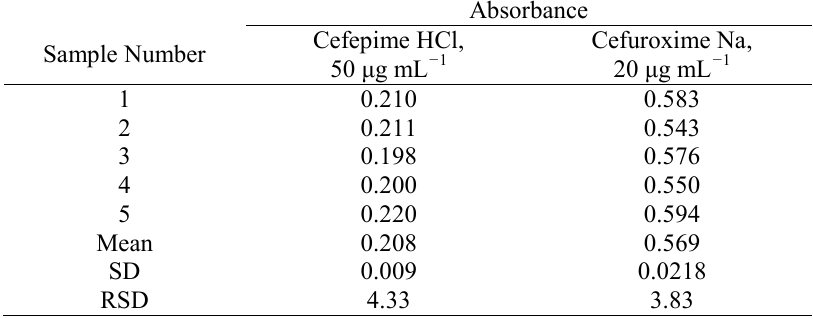
Table 5. Replicate analysis of the examined drug solutions by the proposed